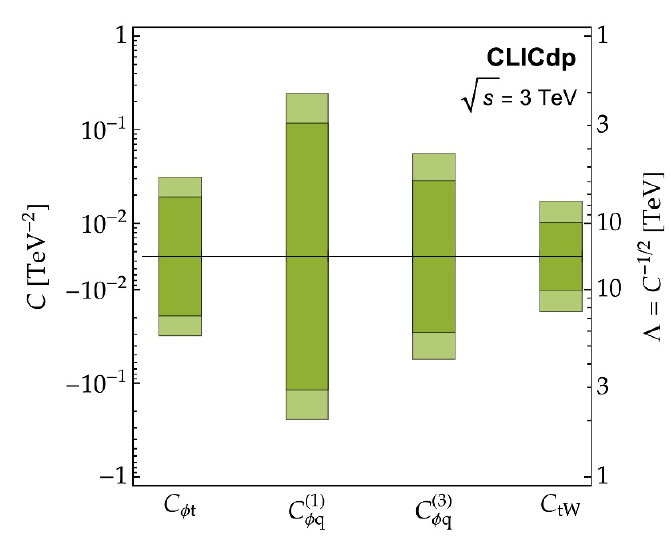
Figure 25. Single-operator sensitivity (68%) from vector boson fusion top-quark pair production at the 3 TeV CLIC. Both upper and lower limits are reported simultaneously on each side of the horizontal line. The stronger limits (dark green) assume perfect top-quark reconstruction and no systematic uncertainties; the weaker ones (light green) are derived with 50% tt reconstruction e(cid:14)ciency and 3%